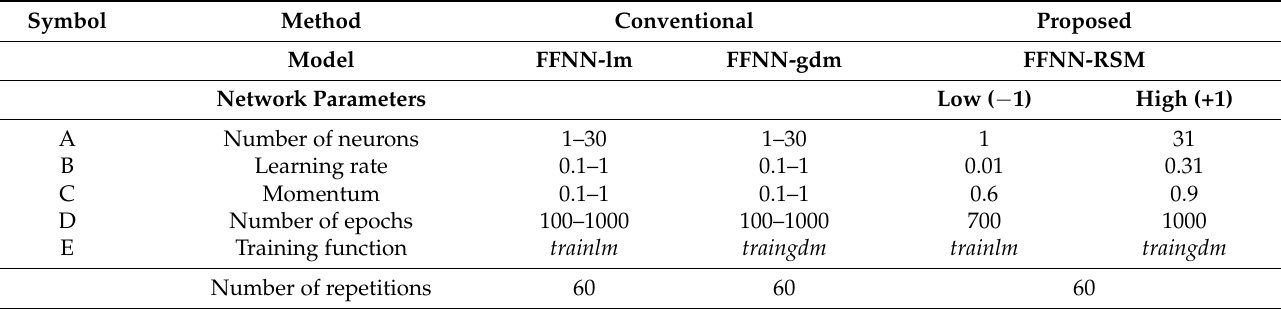
Table 2. The range of ANN training parameters for conventional and RSM